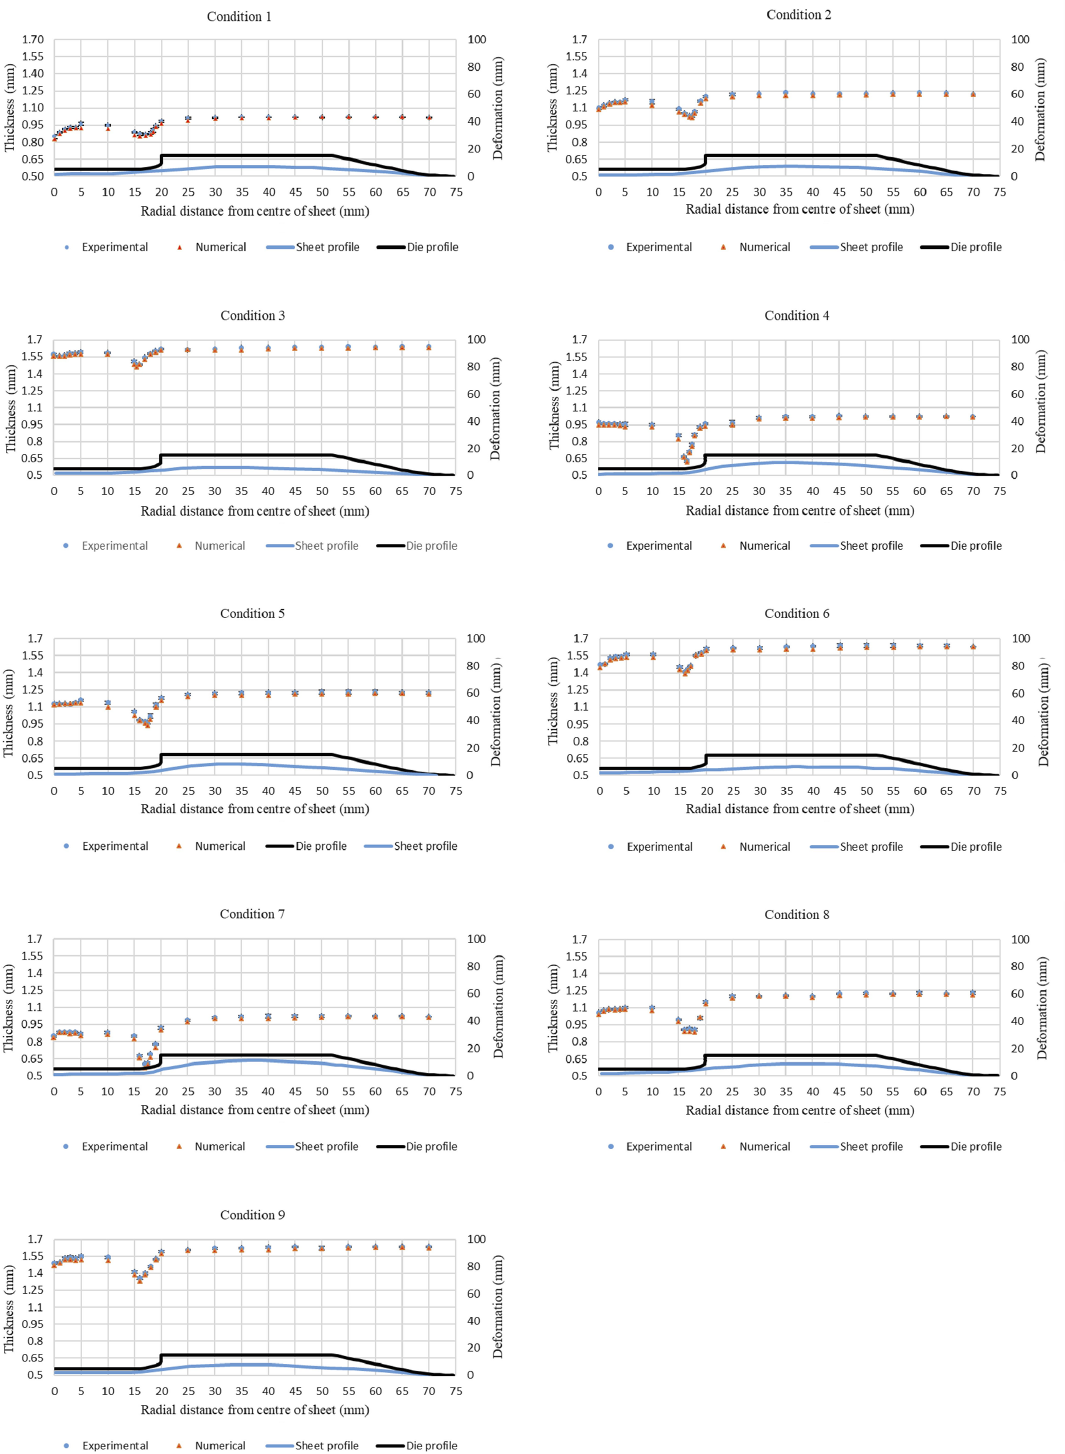
Figure 17. Numerical and experimental thickness of the sheet-on-sheet profile. (a) Voltage = 2400V, thickness = 1.02mm, N = 6. (b) Volt- age = 2400V, thickness = 1.22mm, N = 5. (c) Voltage = 2400V, thickness = 1.63mm, N = 4. (d) Voltage = 2600V, thickness = 1.02mm, N = 5. (e) Voltage = 2600V, thickness = 1.22mm, N = 4. (f) Voltage = 2600V, thickness = 1.63mm, N = 6. (g) Voltage = 2800V, thick- ness = 1.02mm, N = 4. (h) Voltage = 2800V, thickness = 1.22mm, N = 6. (i) Voltage = 2800V, thickness = 1.63mm, N =